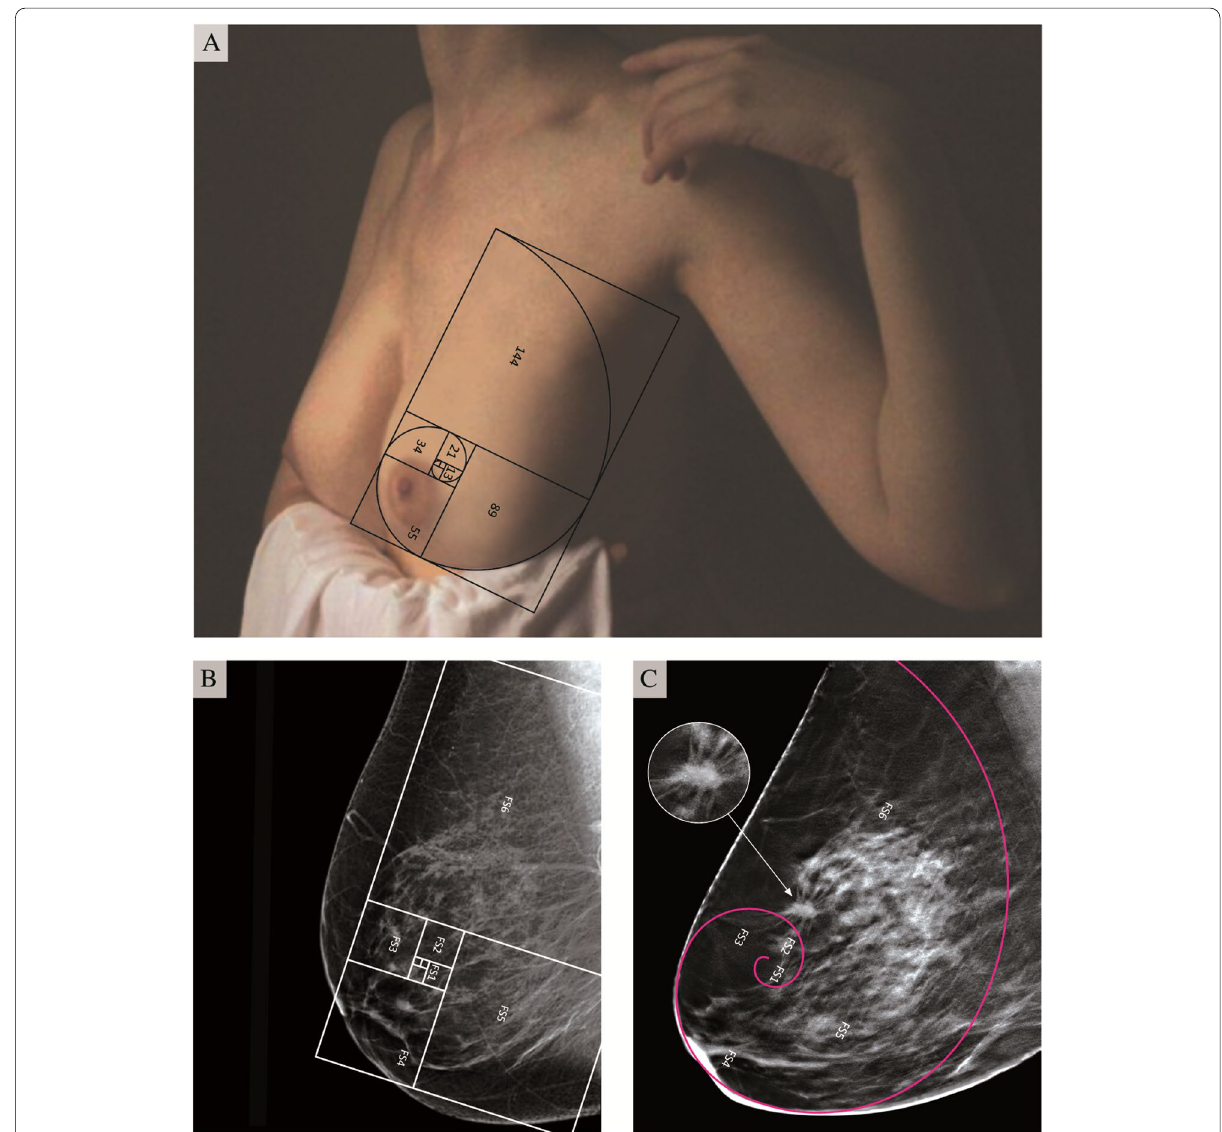
Fig. 2 PhiΦBreast A New Diagnostic Technique For Breast Cancer Detection. A show the fascinating symmetry of the breast that ultimately can be rapresented by Golden Spiral inscribed in the regular breast anatomy. B show mediolateral oblique view (MLO) of the breast at mammographic X-ray with applied Golden Ratio and Fibonacci numbers of healthy individual. No nodules were detected along the Golden Ratio. C PhiΦBreast imaging applied to the mammogram has provided a mapping of neoplastic lesion. White arrow highlights cancerous tumor detected in FS6 side of the Golden Spiral. Cancerous mass appear as a bright and irregular image with spiky